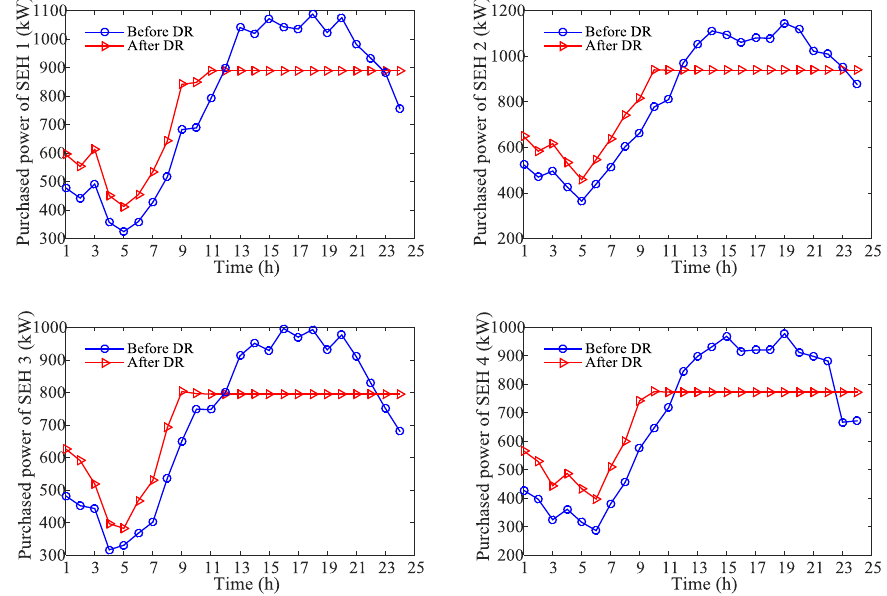
Figure 7. Hourly power demands of all EHs before and after DR. Energies 2018 , 11 , x FOR PEER REVIEW